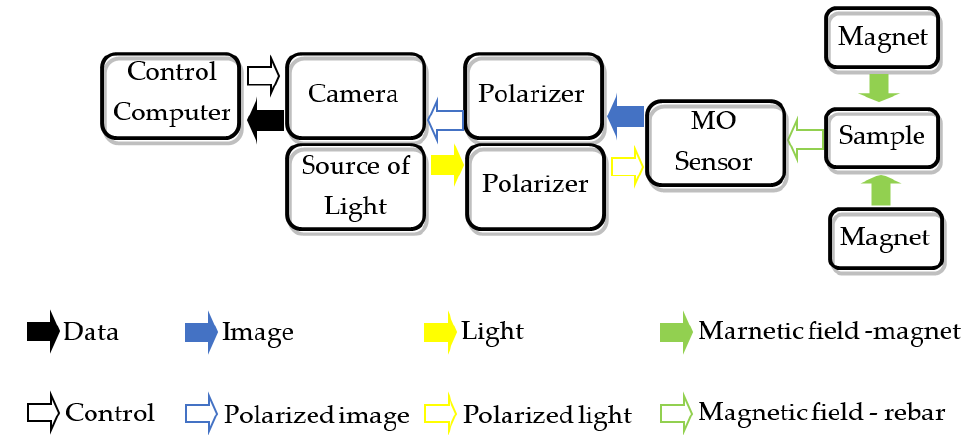
Figure 10. Block diagram of the system with the MO-sensor.